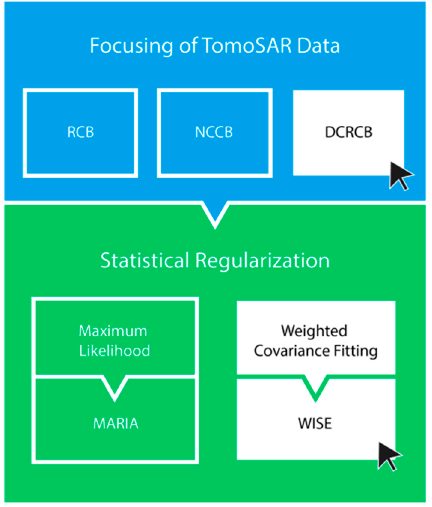
Figure 1. Proposed methodology to perform single-look TomoSAR over urban areas. For demonstration purposes, we refer to the techniques highlighted in white.